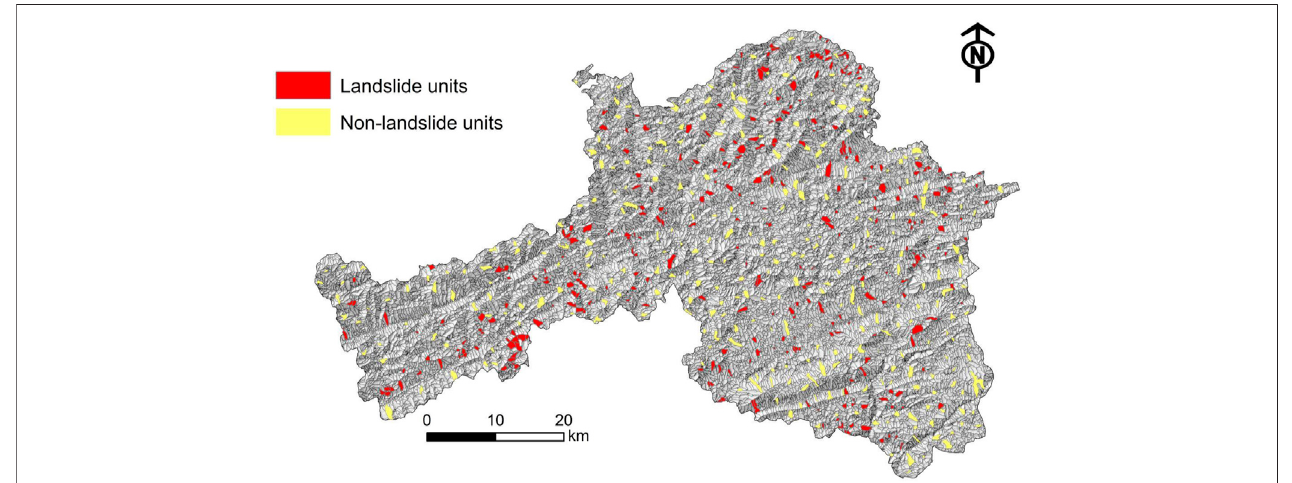
FIGURE 3 | Slope unit division of the